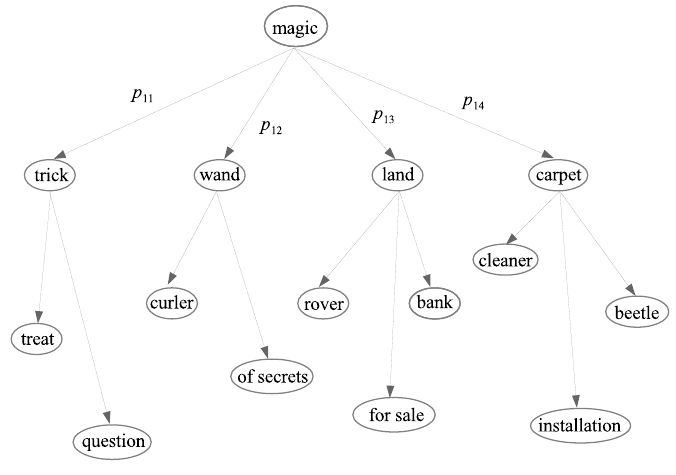
Figure 3. An example of directional tree of words in a